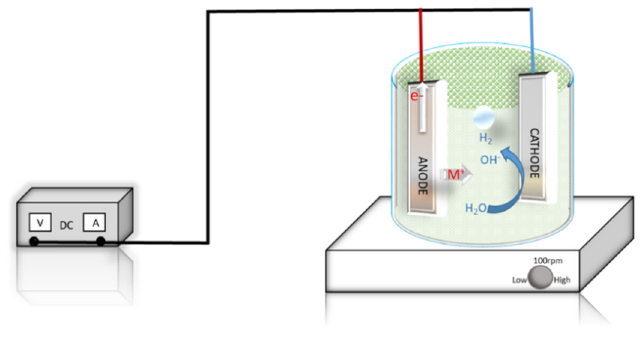
Figure 1. Experimental setup of the electrocoagulation process.